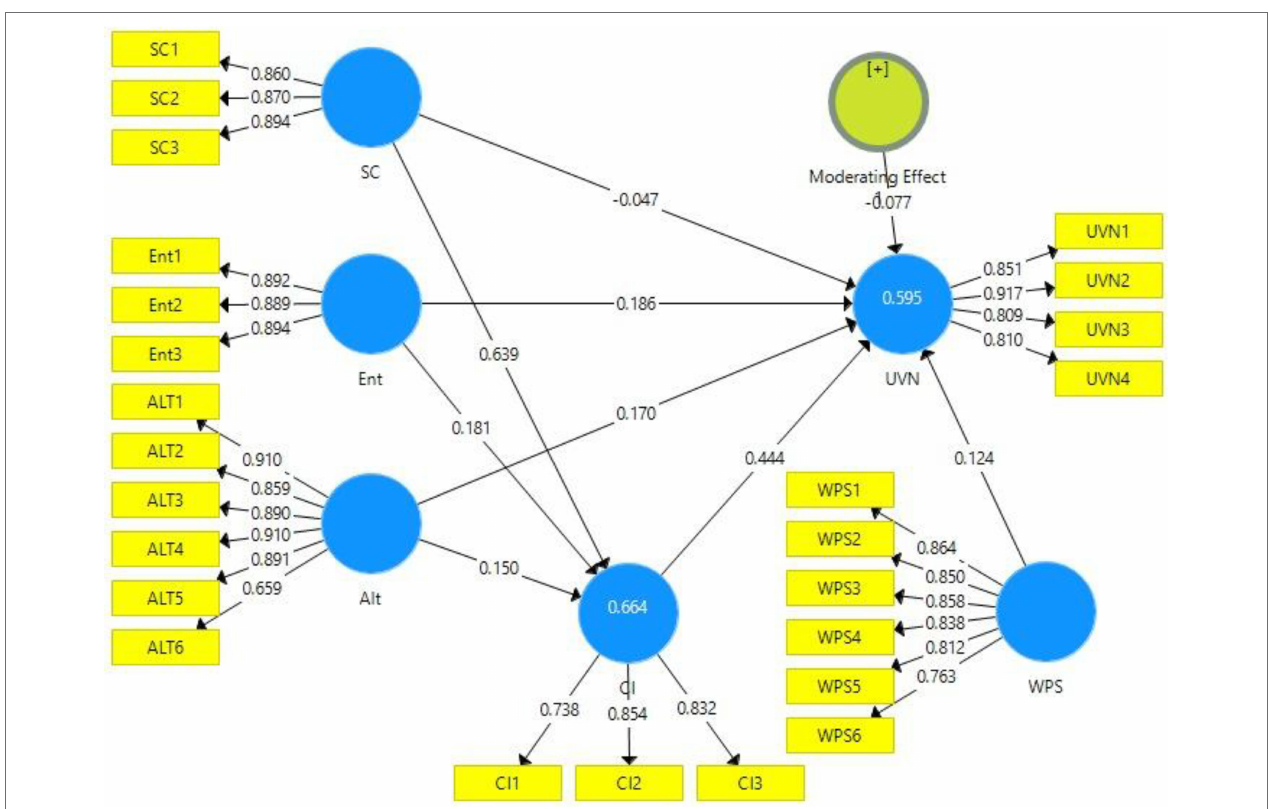
FIGURE 3 | Output of measurement model with moderation. SC, Social Consciousness of Employees; Ent, Entertainment; Alt, Altruism; UVN, Unverified News Sharing; CI, Corporate Image; and WPS, Workplace